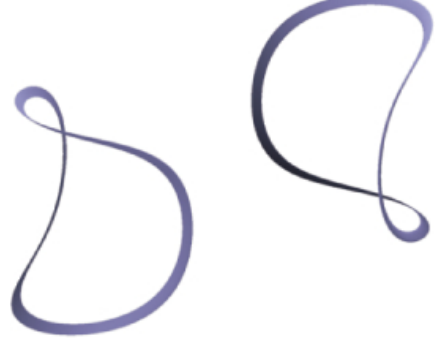
Figure 6. The variety V ( I 17 ) given by Eq. (14). makes 20 variables. Then we have 6 revolute joints.